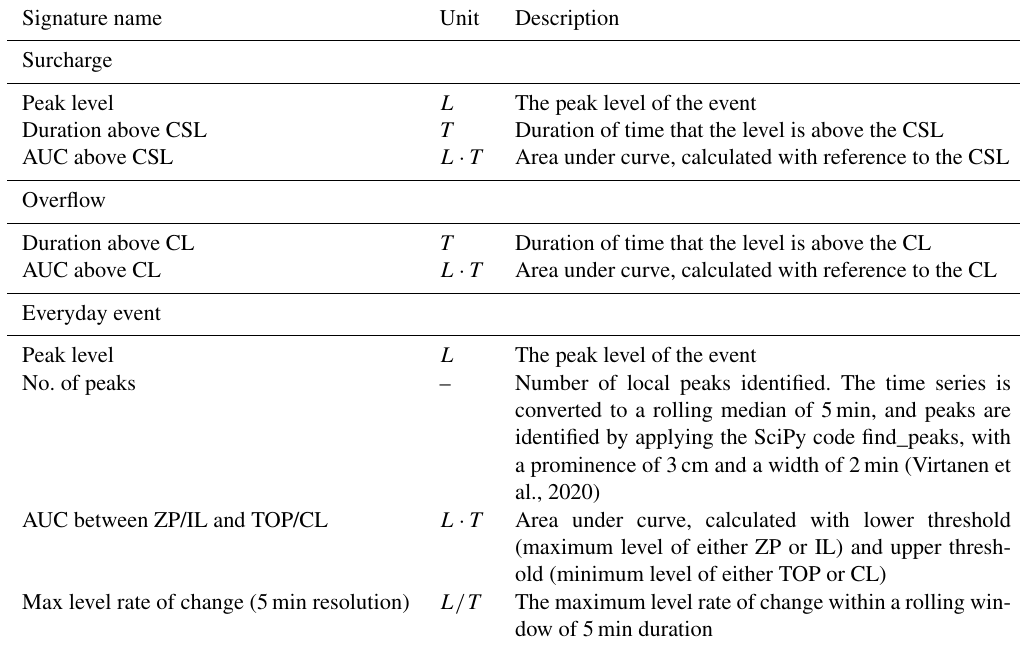
Table 1. Relevant signatures included for the analysis of three defined model objectives. Units are L = for length and T = for